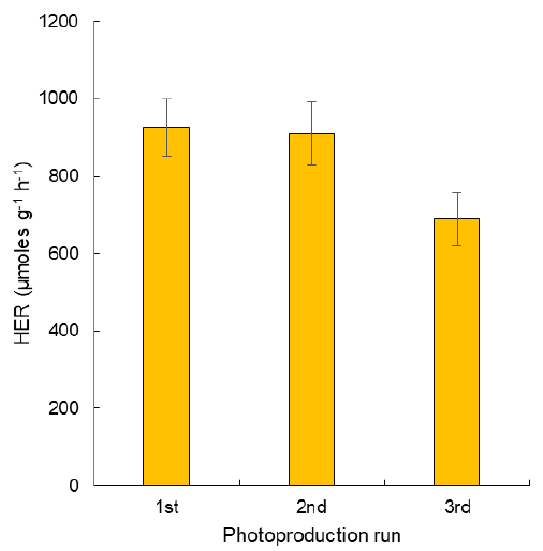
Figure 4. Reusability of DMASnBr 3 / g-C 3 N 4 (0.5 g L − 1 , 0.5 wt% Pt, 0.2 M aqueous glucose), RSD < 11% ( n = 3).